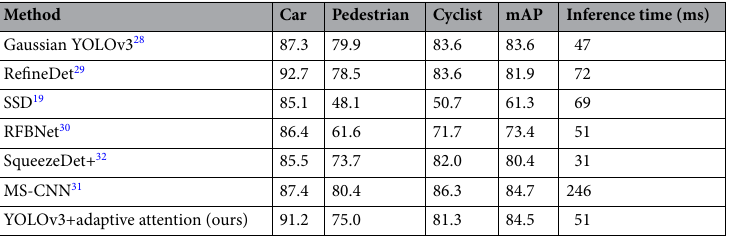
Table 2. Evaluation results on KITTI